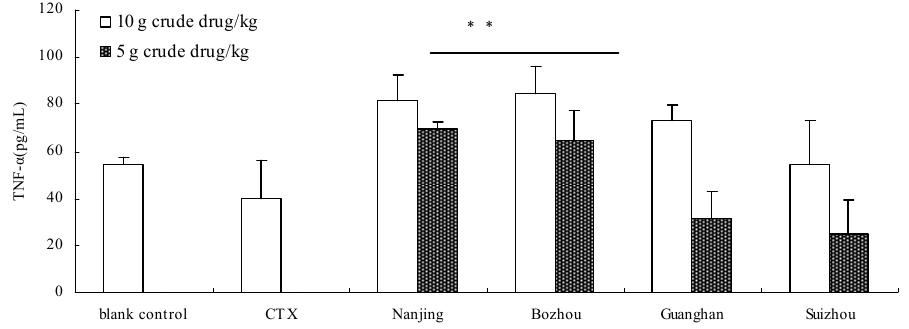
Figure 4. Comparison of TNF- α content in serum of tumor-bearing mice.